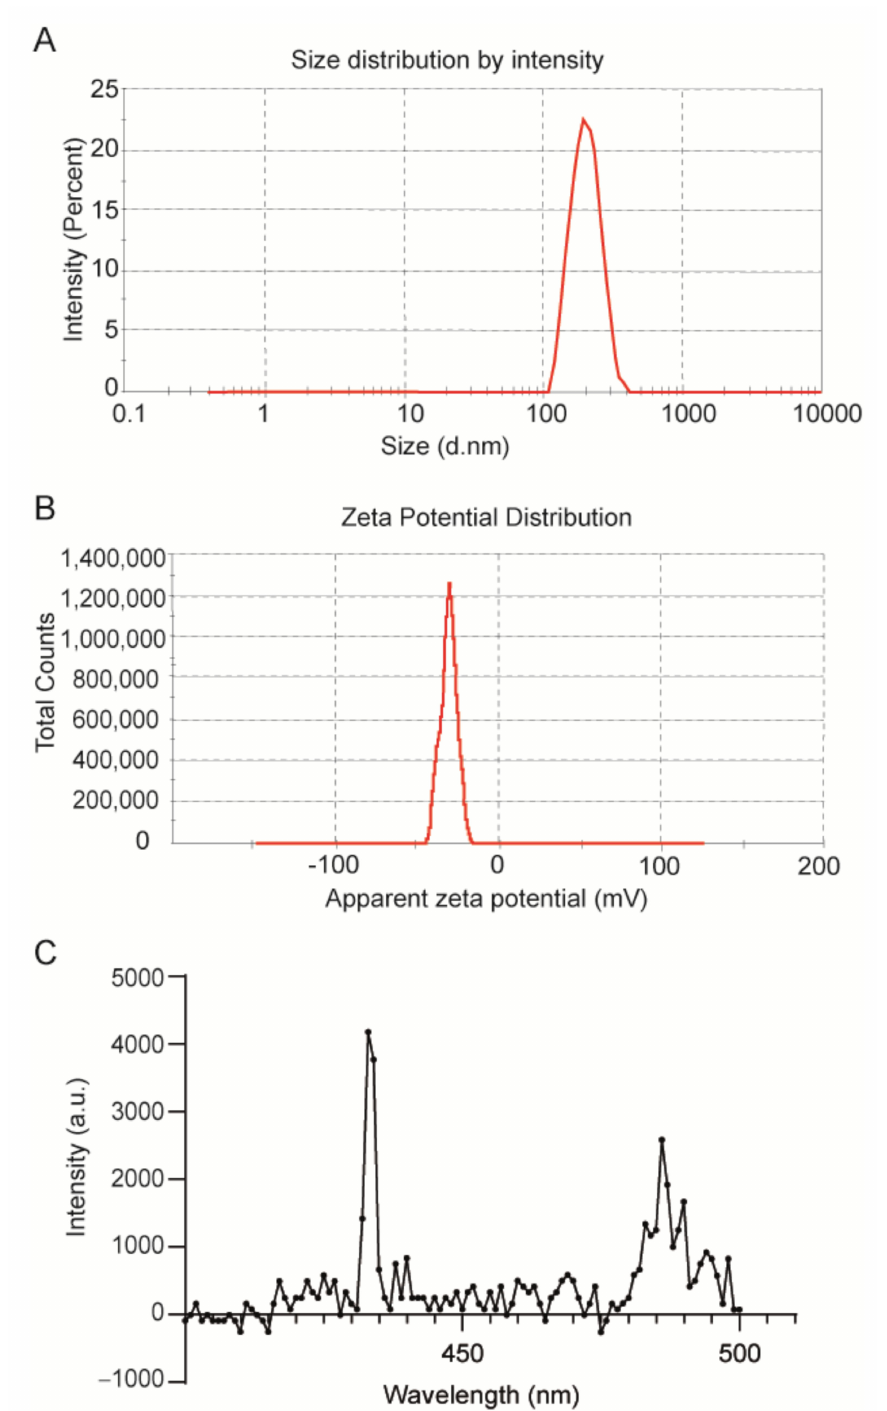
Figure 3. Physicochemical characterization of TTA-UC-PLGA-NPs. Representative ( A ) dynamic light scattering and ( B ) zeta-potential measurement of TTA-UC-PLGA-NPs reconstituted in water after freeze-drying. The average size of the nanoparticles was 198 nm in diameter, and the average zeta potential value was − 31 mV. ( C ) TTA-UC-PLGA-NPs were dissolved in water and directly analysed. The NPs in solution were excited at 535 nm, and the emission was collected using a